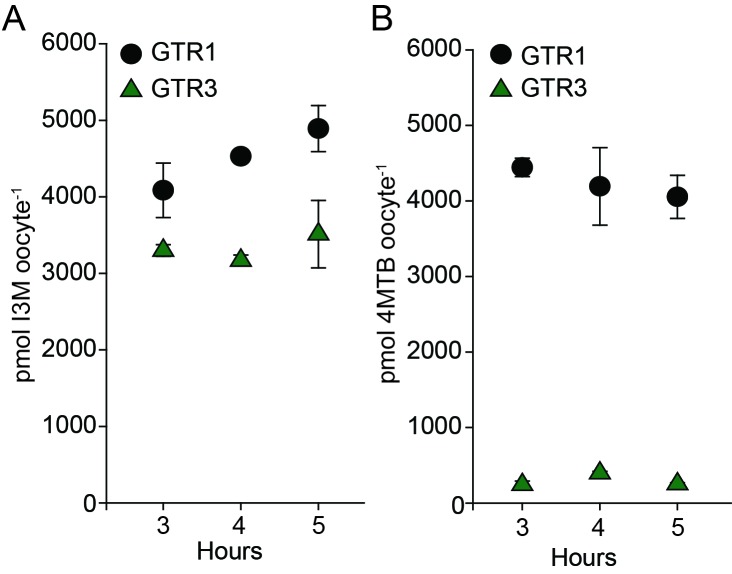
Uptake of 4MTB and I3M by GTR1 and GTR3 expressed in X. laevis oocytes.(A–B) Time-dependent I3M (A) and 4MTB (B) uptake by GTR1- and GTR3-expressing oocytes. This data was shown in Figure 2 as up-concentration relative to assay media concentration. Here substrate amounts are shown in pmol per oocyte. Accumulated 4MTB or I3M was quantified by LC-MS in 3 × 5 oocytes for each gene after 3, 4 and 5 hr of incubation in a standard pH5 kulori buffer containing 0.2M I3M or 0.2 µM 4MTB. Error bars represent ± s.d. of mean for data, n = 3.